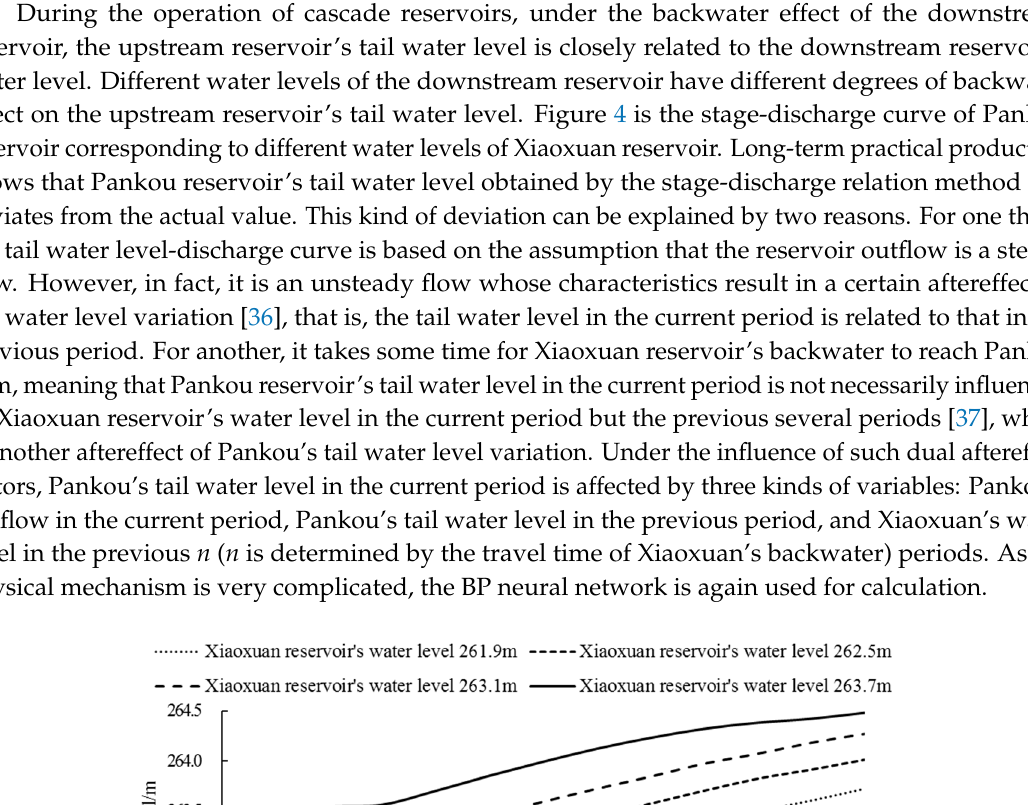
Figure 3. Calculation results of Xiaoxuan’s inflow.